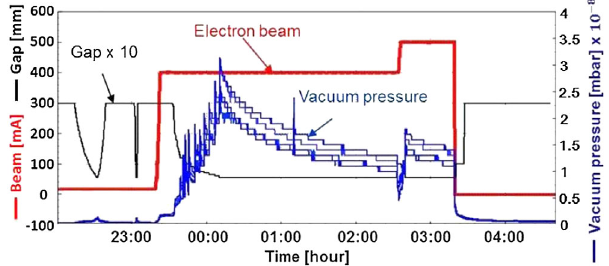
FIG. 18. Undulator vacuum pressure variation versus gap at high electron beam current of 400 mA.